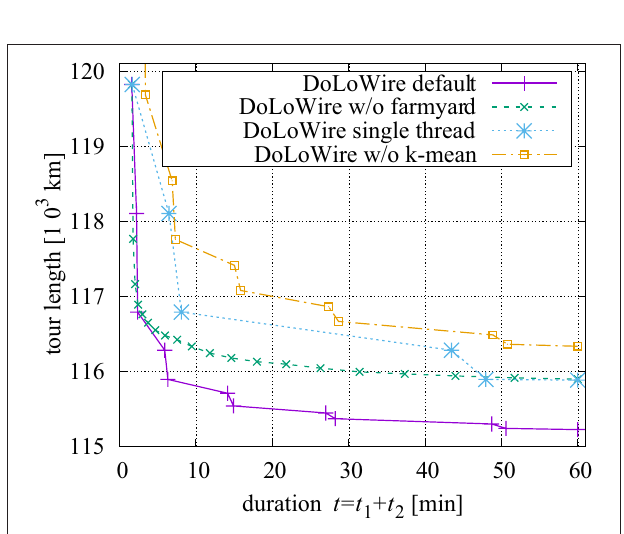
FIGURE 8 | Influence of farmyard moves (initial tour with maxCP maxSP 300, t 1 100 s), multi-threading, and cluster = =